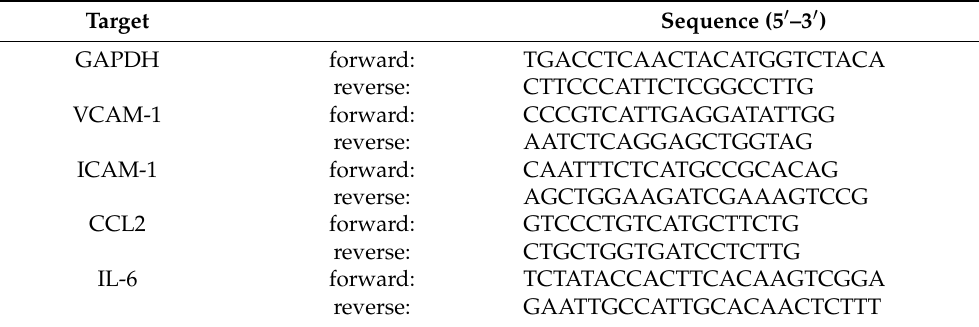
Table 1. Primer pairs for